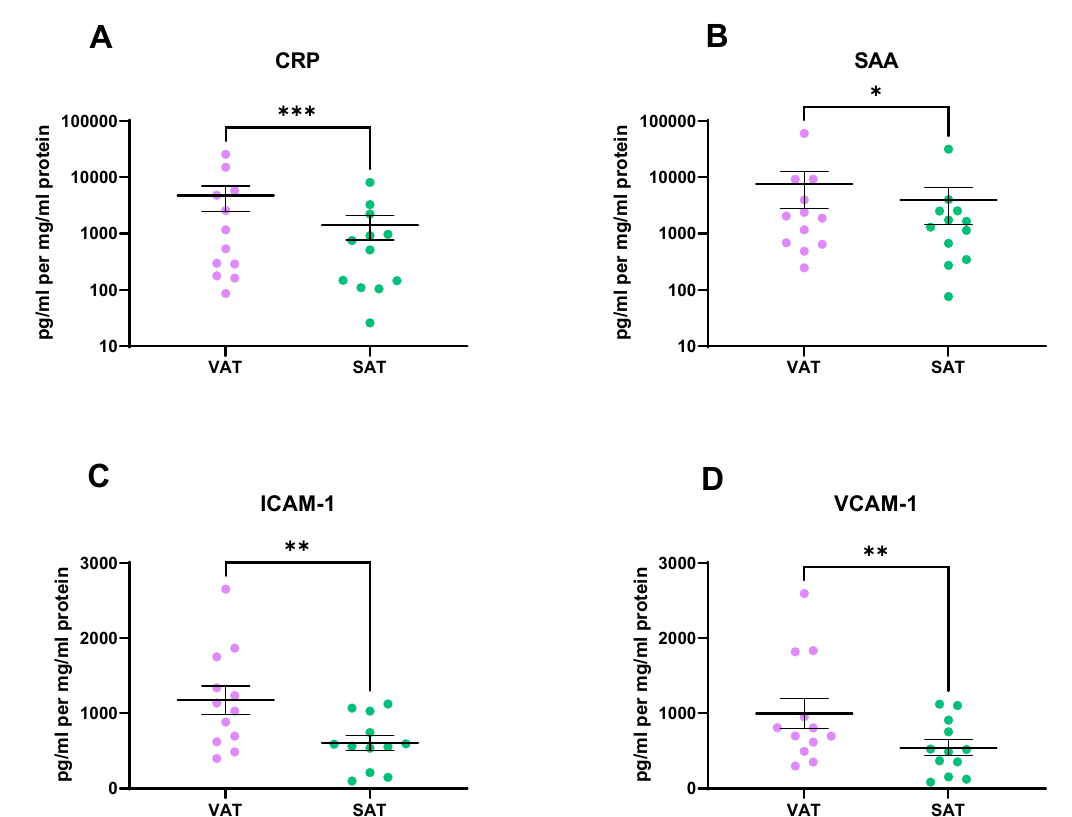
Figure 5. Vascular injury secretions are higher in the visceral adipose tissue (VAT) secretome when compared to the subcutaneous adipose tissue (SAT) secretome. ( A ) CRP, ( B ) SAA, ( C ) ICAM-1, and ( D ) VCAM-1 are secreted at significantly higher levels from VAT compared to SAT. Statistical analysis was performed using a Wilcoxon signed rank test. All data expressed as mean ± SEM. n = 12, *** p < 0.001, ** p < 0.01, * p < 0.05. Table 1. Correlation of metabolic parameters with secreted factors from VAT and